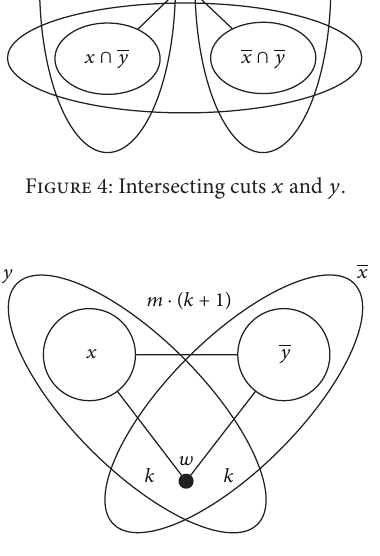
Figure 5: Cuts 𝑥 and 𝑦 with one element in the